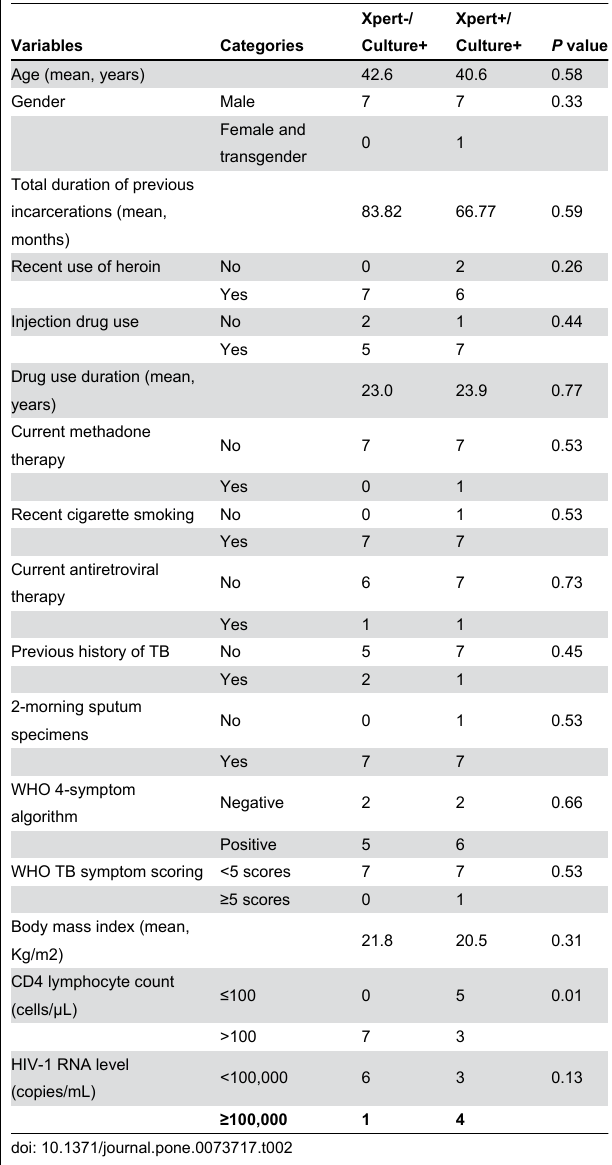
Table 2. Comparative analysis between Xpert-negative/ Culture-positive and Xpert-positive/Culture-positive